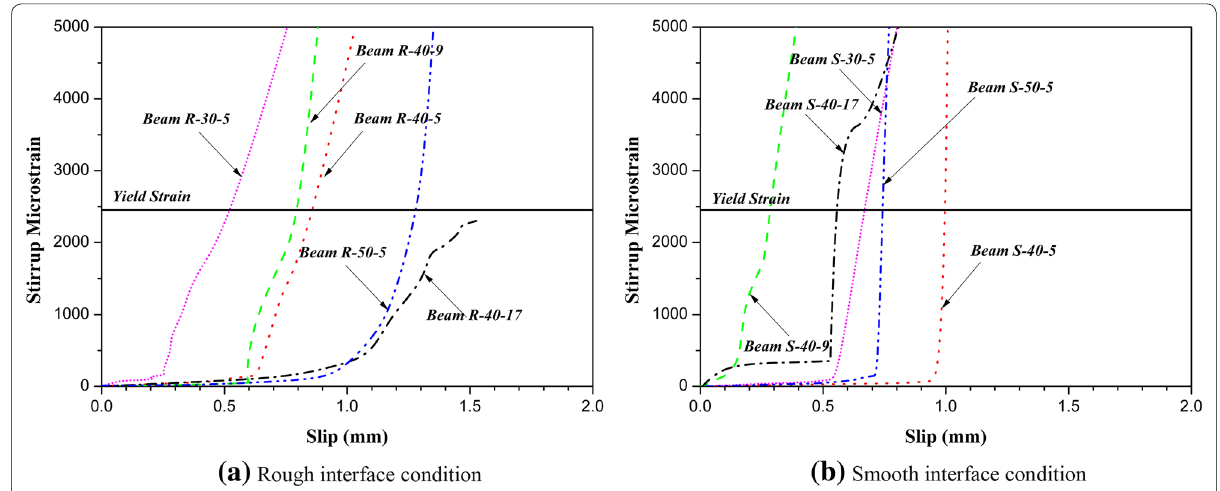
Fig. 11 Typical slip-strain curves at the location of maximum slip in the test